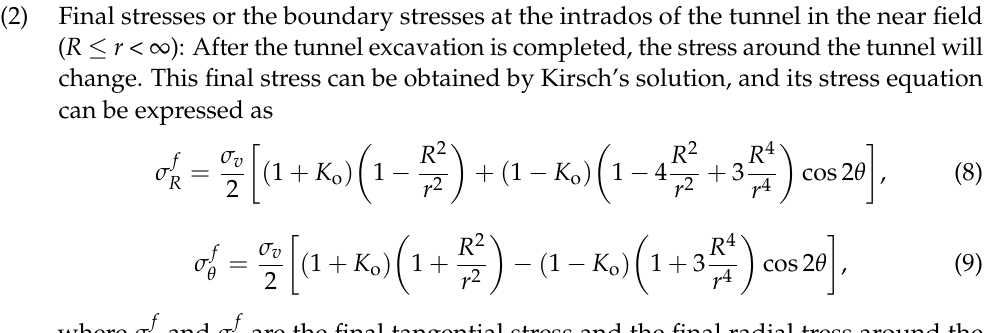
Figure 3. Schematic diagram of the stress change around a circular tunnel from the near-field to the far-field stress.